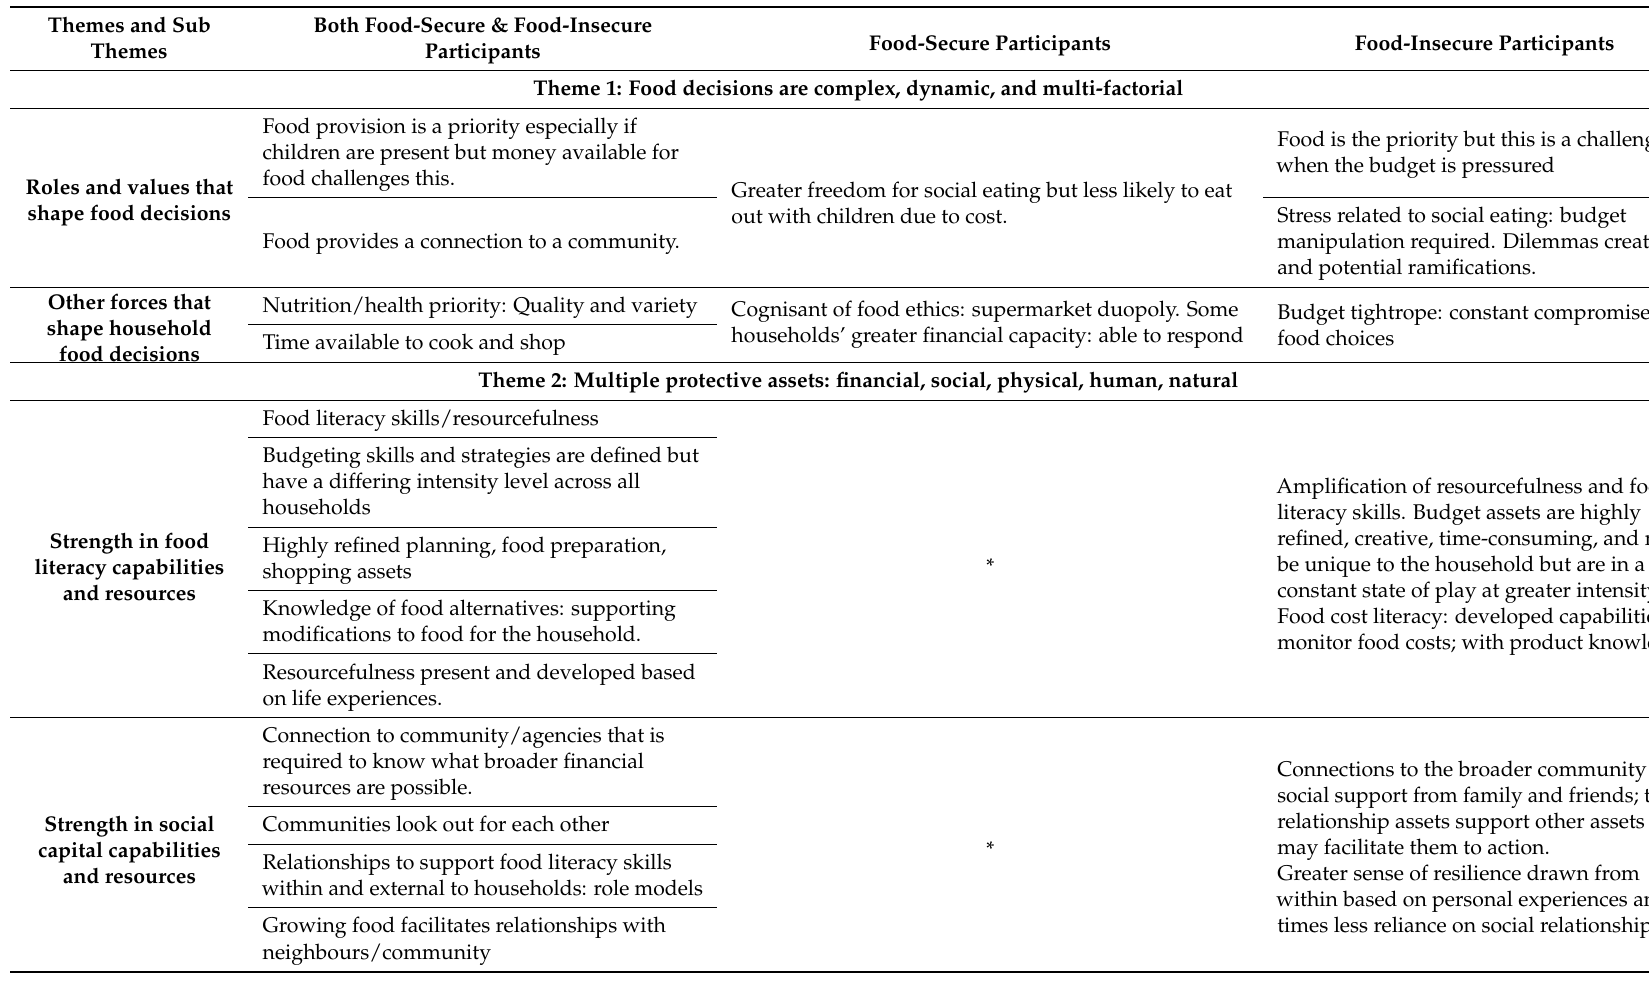
Table 2. Summary of theme and subtheme comparison between and across the food-secure and food-insecure